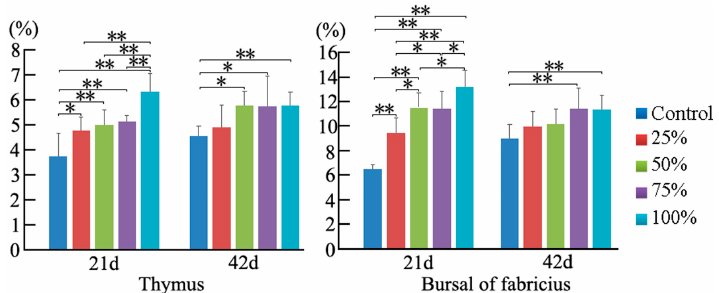
Figure 6. Effects of AFB-contaminated corn on the percentages of apoptotic cells in the thymus and BF of chickens. ** represents the significant difference ( p < 0.01). * represents difference ( p < 0.05).